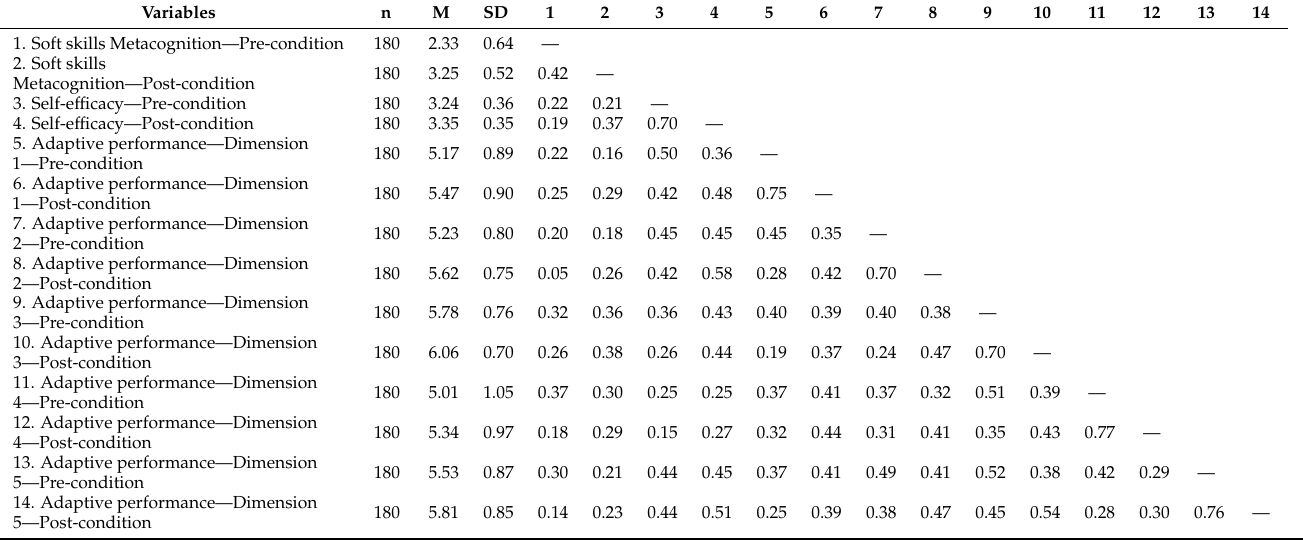
Table 3. Descriptive statistics of the main